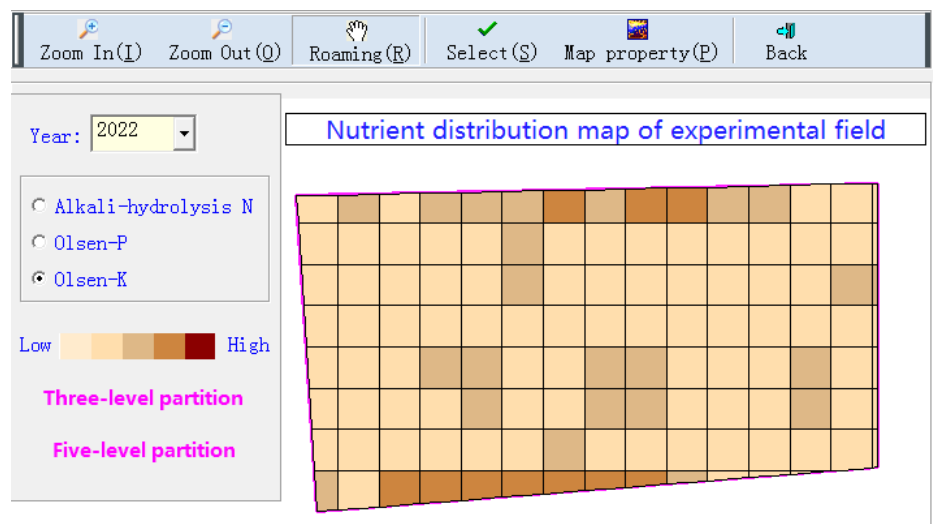
Figure 7. Distribution map of soil available potassium in the three-level partition.